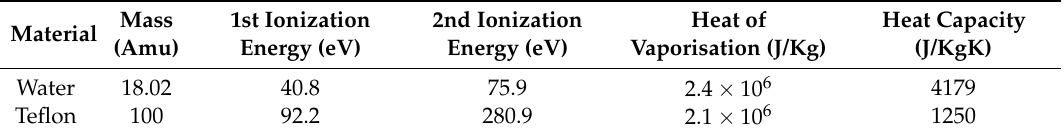
Table 1. Material property for Water and